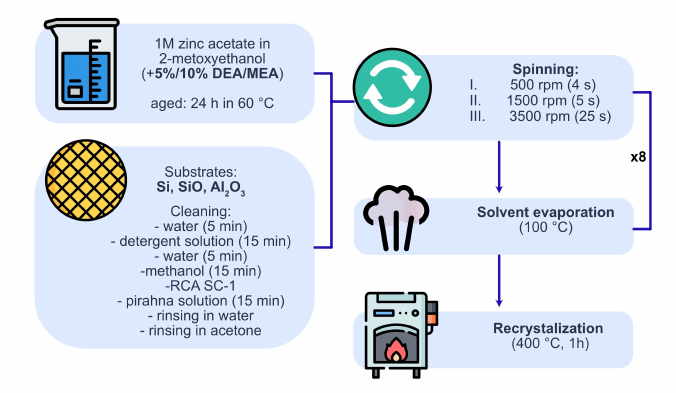
Figure 1. The algorithm of samples’